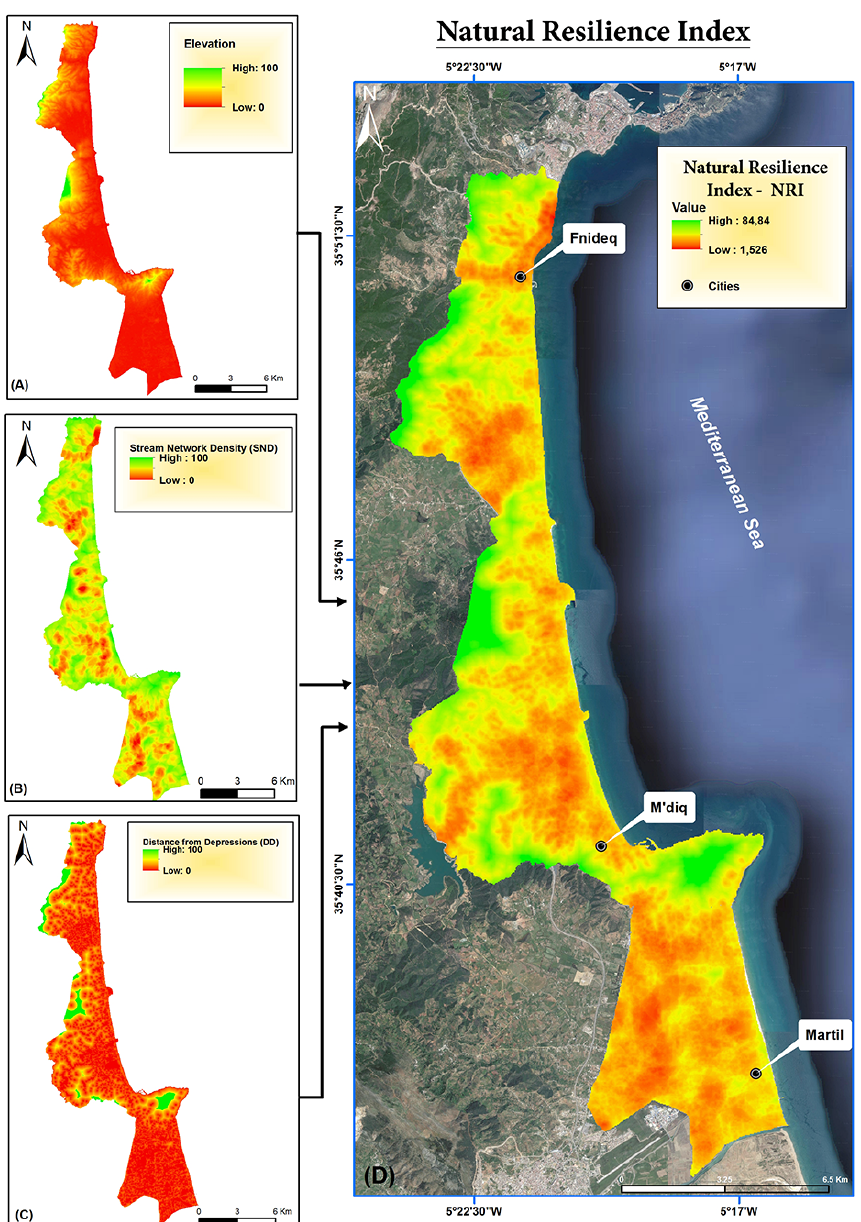
Figure 6. Spatial distribution of (a) elevation, (b) stream network density, (c) distance from depressions, and (d) natural-resilience index (obtained from © Google Maps